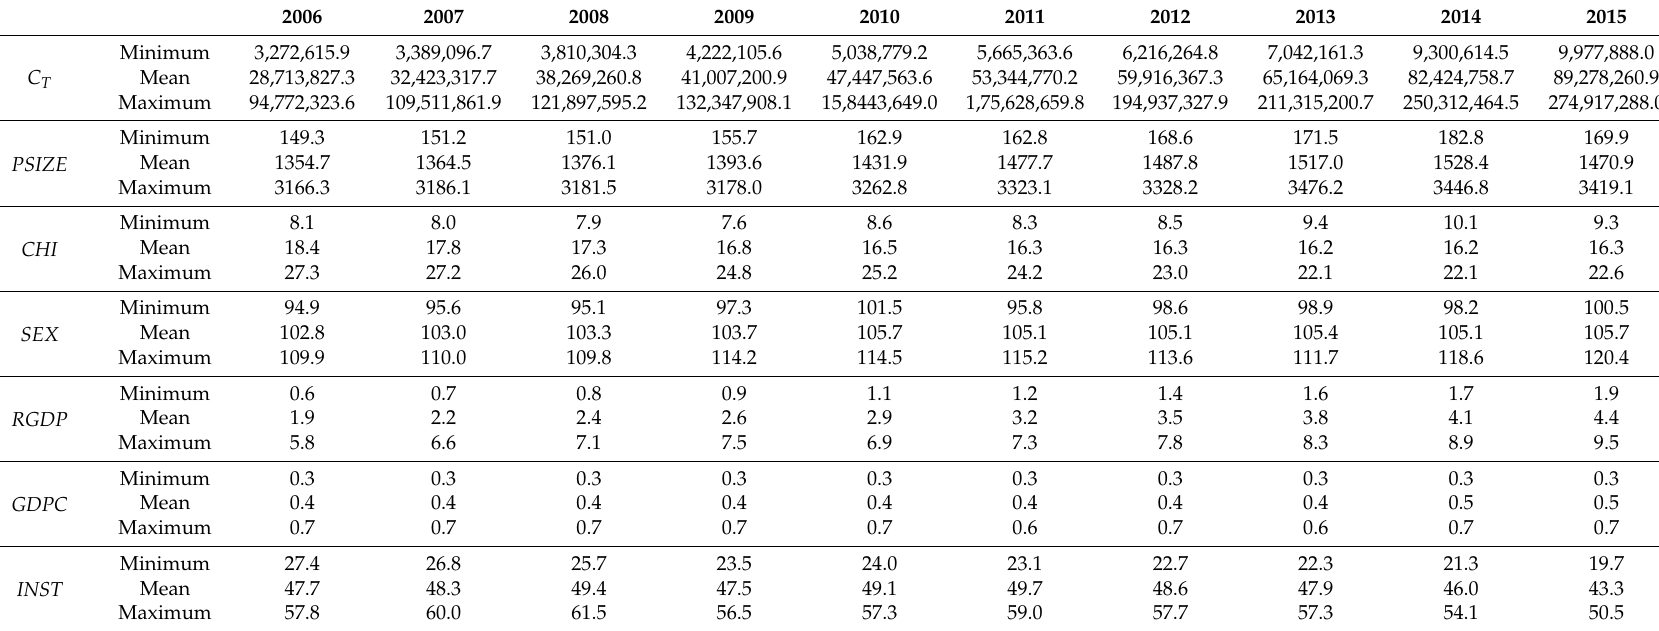
Table 5. Summary statistics for pooled data ( n =